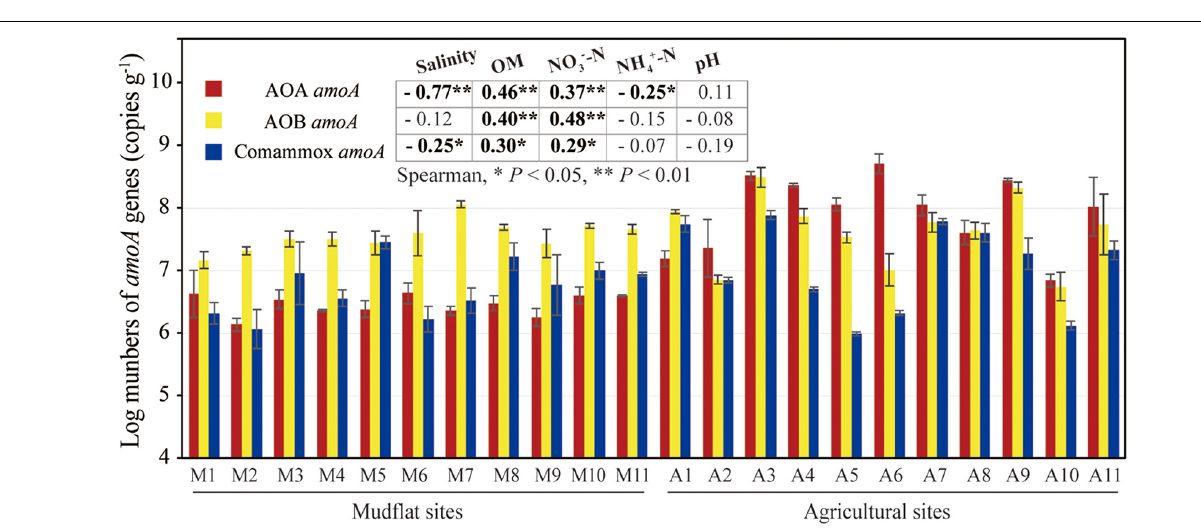
FIGURE 2 | AOA, AOB and comammox Nitrospira amoA gene copy numbers in mudflat (M1–M11) and reclaimed agricultural soils (A1–A11). The mean values of amoA copy numbers were obtained from triplicate samples. Embedded chart shows the correlation between the amoA gene numbers and soil properties based on spearman rank (* P < 0.05, ** P <